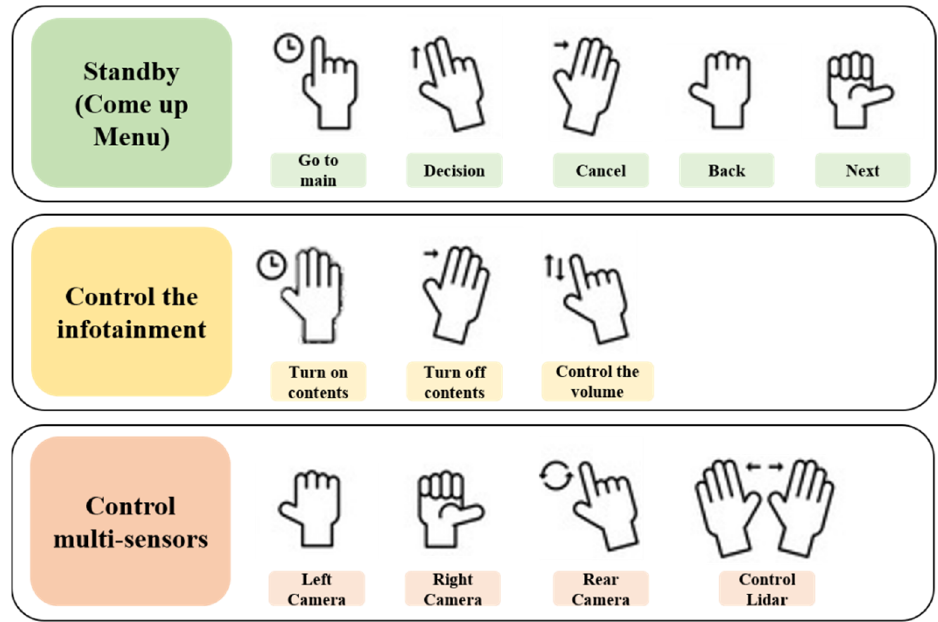
Figure 6. Example scenario based on the recognition of various gestures.